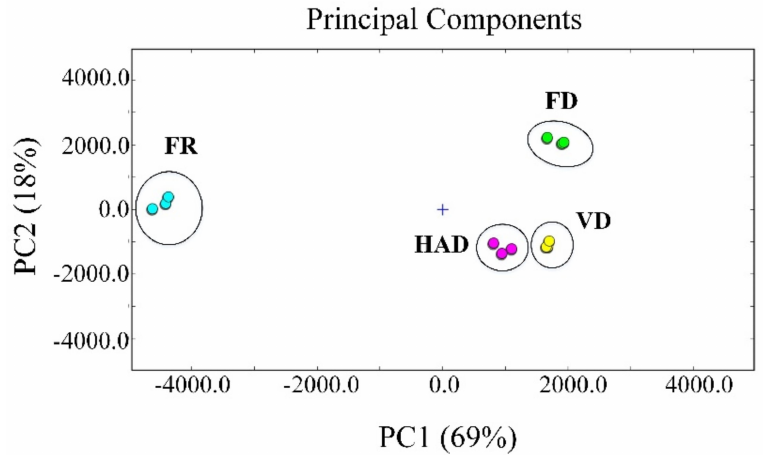
Figure 4. PCA analysis plot of the flavor of the fresh and dried AMR samples treated by using different drying